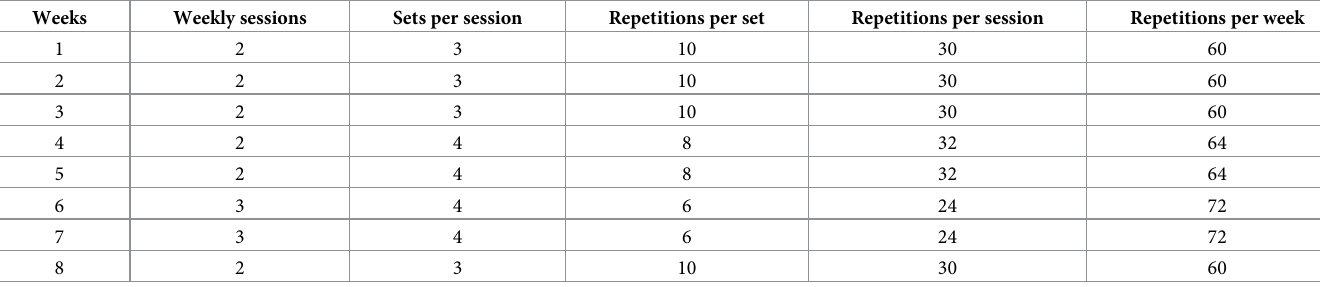
The values represent one exercise per muscle group. The SJ group performed twice the number of repetitions as the MJ group, but divided between the knee extensors and hip